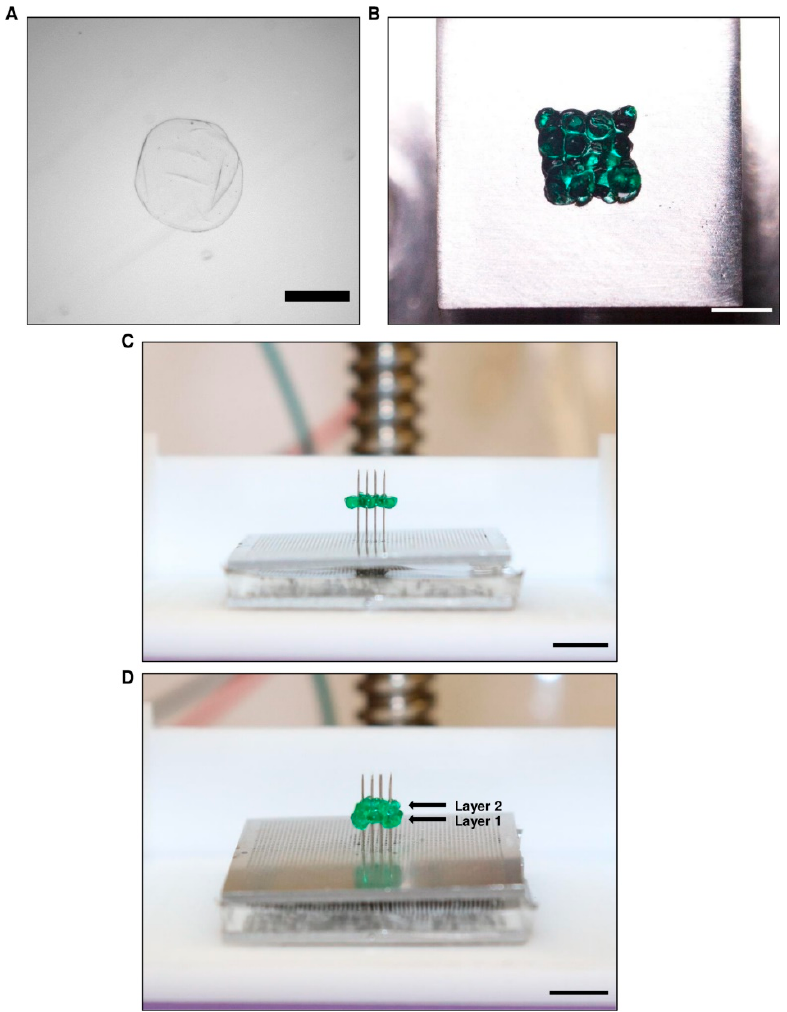
Figure 5. Bioprinter testing with alginate beads. Soft alginate beads were used as a spheroid surrogate as they could easily be punctured and placed on the bioprinter needles. ( A ) The beads were synthesized at an average diameter of 851 ± 15 μ m, which was similar to the spheroid diameter. ( B – D ) Picture ( B ) showing beads aspirated onto the end of a 4 × 4 arrangement print head and ( C ) printed onto the needles in a single layer. ( D ) Two layers were also tested to ensure that multiple layers could be printed. Scale bars: ( A ) 500 μ m; (B) 2 mm; ( C ) and ( D ) 5 mm.